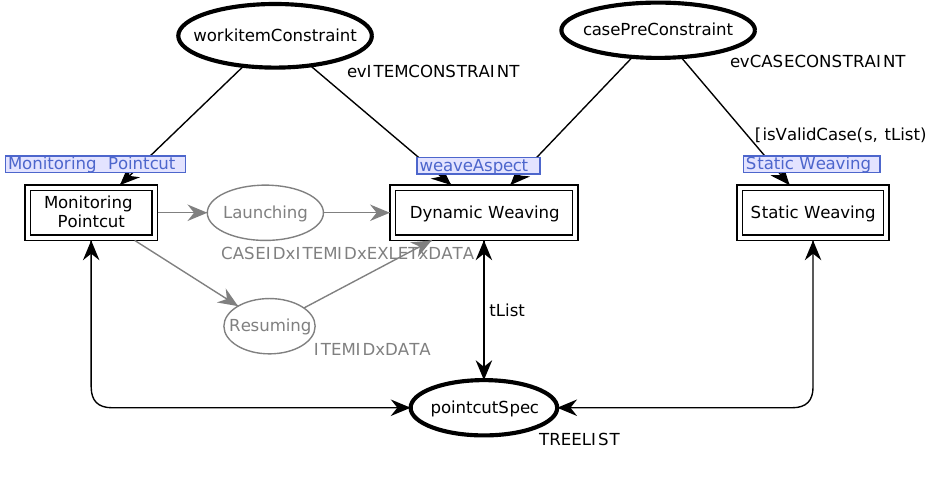
Figure 6. The Hybrid Weaving net